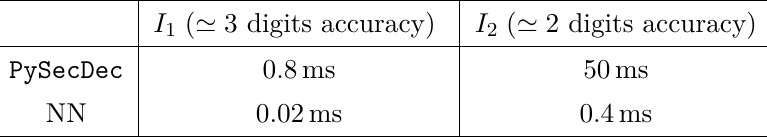
Table 2 . Comparison for the approximate evaluation time of the integral using our method and pySecDec